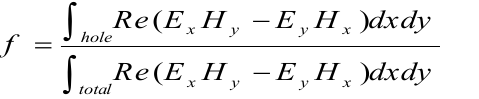
TABLE I. The value of the proposed PCF parameters parameter